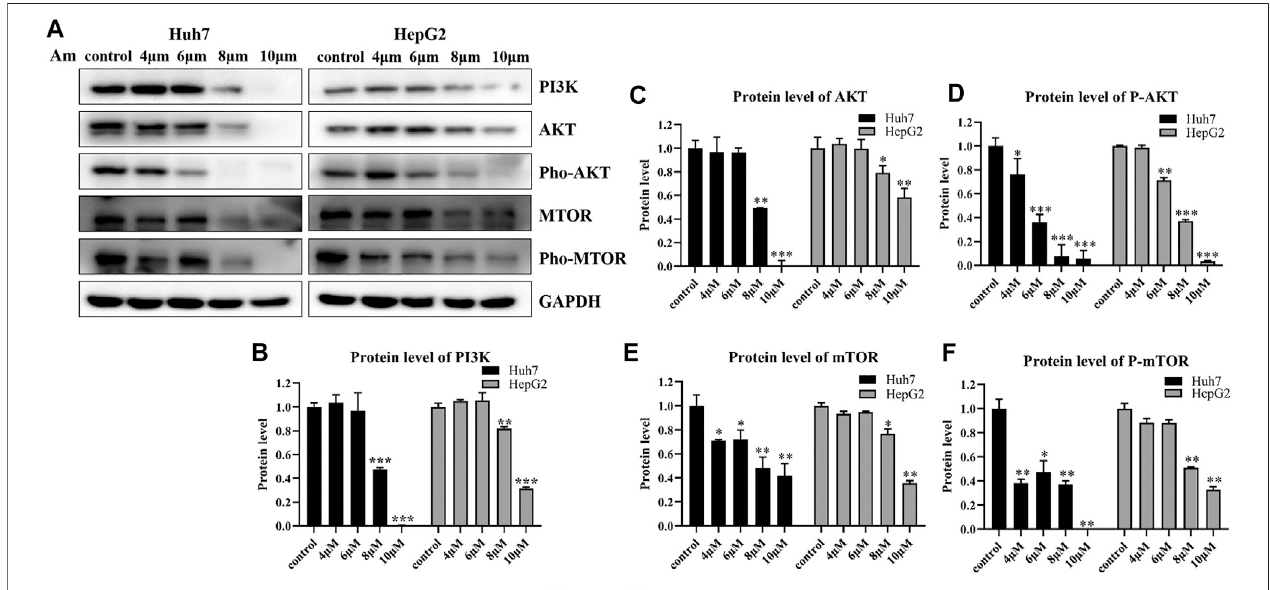
FIGURE5| Aminoquinolreducedtheexpressions ofkeyproteins inthePI3K/AKT/mTORpathway (A) Western blotanalysisofHuh7 andHepG2cellstreatedwith indicatedconcentrationsofaminoquinolfor6 h (B – F) Thequanti fi eddataof (B) PI3K, (C) AKT, (D) p-AKT, (E) mTOR,and (F) p-mTOR.Datawerepresentedasmeans ± standard deviation. * p < 0.05, ** p < 0.01, *** p < 0.001, signi fi cantly different from the control